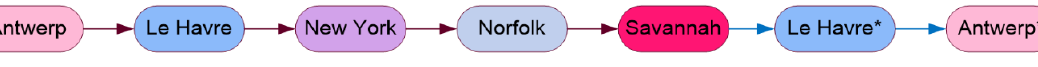
Figure 2. The port rotation graph example.